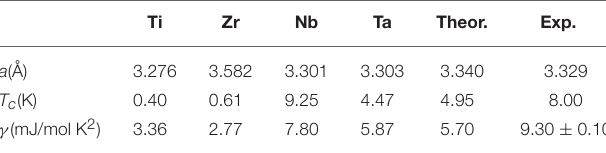
TABLE 1 | Lattice constant a (Koželj et al., 2014), SC transition temperature T c ( Ashcroft and Mermin, 1976) and the specific heat coefficients γ (Tari, 2003) of pure constituent elements and the investigated Ti 15 Zr 15 Nb 35 Ta 35